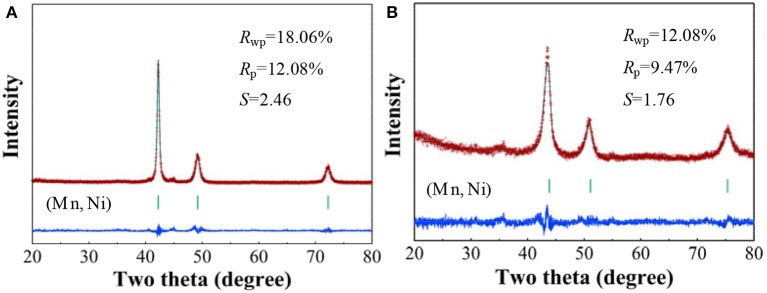
Rietveld refinements of the observed XRD patterns for Mn70Ni30 alloy (A) before and (B) after dealloying.